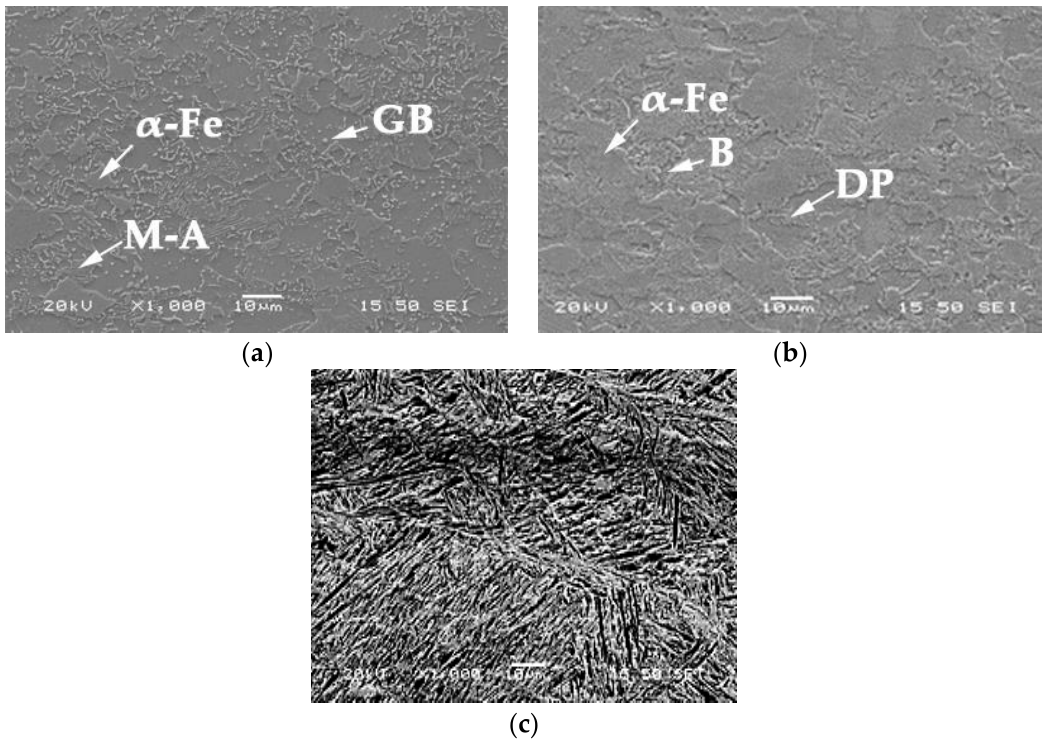
Figure 7. SEM metallographic images from ( a ) base metal; ( b ) heat affected zone and ( c ) fusion zone of the AISI 4130 welded sample. (Marked phases: α -Fe: ferrite, GB: granular bainite, B: bainite, DP: degenerated pearlite).